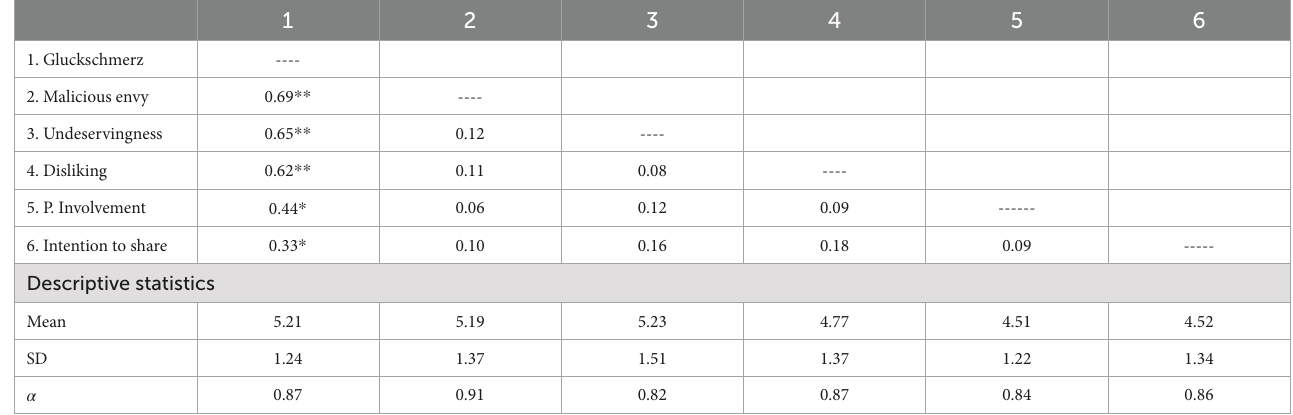
TABLE 3 Descriptive statistics and correlation among Study 2